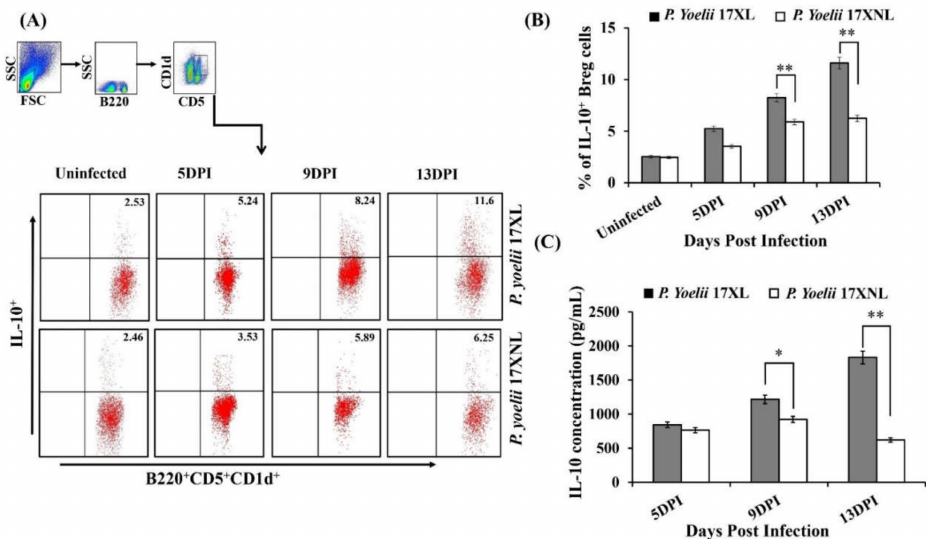
Figure 3. Immune dynamics of Bregs (regulatory B cells) during malaria infection with a lethal ( Py 17XL) and non-lethal ( Py 17XNL) strain of Plasmodium : Female Balb/c mice were intra- peritoneally (i.p) infected with 5 × 10 5 Plasmodium yoelii 17XL and Plasmodium yoelii 17XNL parasitized Red Blood Cells. ( A ) Spleen cells from Plasmodium parasite infected and control mice were harvested and stained with fluorescently labelled antibodies against B220, CD5, CD1d and IL-10 at 5th, 9th and 13th days after infec- tion of Plasmodium yoelii 17XL and Plasmodium yoelii 17XNL. Phenotypic characterization of regulatory B cells was done using flow cytometry. ( B ) The percentages of IL-10 producing B220 + CD5 + CD1d + B cells in the spleen. ( C ) Serum profile of IL-10 cytokine after infection with Plasmodium yoelii 17XL and Plasmodium yoelii 17XNL at 5th, 9th and 13th day analyzed by using Luminex micro-bead array system. Data is representative of one of the three independent experiments. Unpaired two-tailed Student’s t test was used to calculate the statistical significance (** p < 0.001, * p <